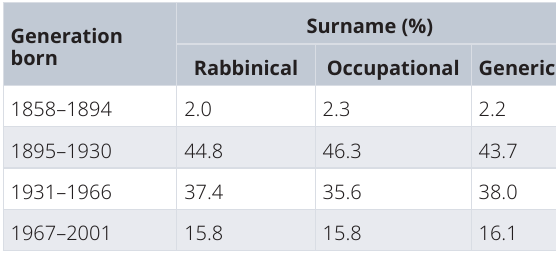
Table 1. Data description showing the percentage of types of surname according to four generations